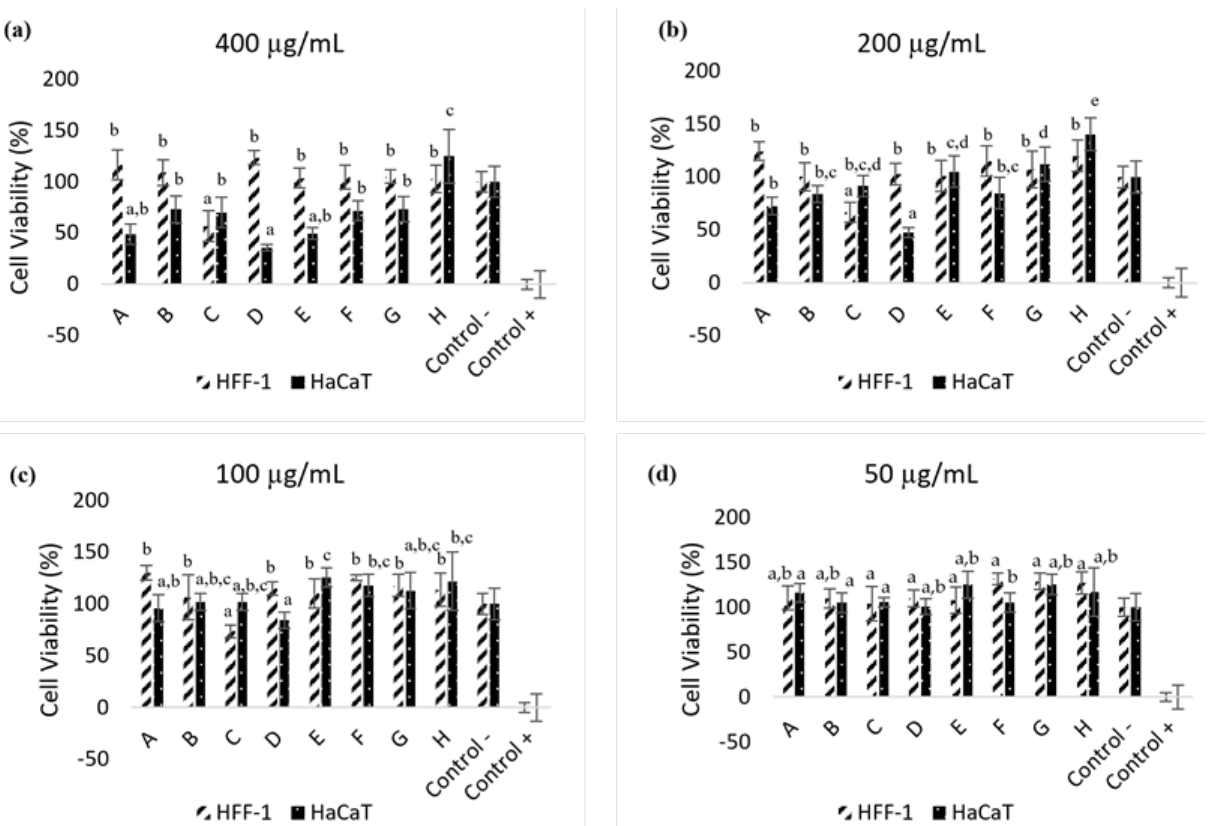
Figure 2. Cell viability effects of hydroethanolic extracts from winemaking residues on HFF-1 and HaCAt cells at different concentrations: ( a ) 400 µ g/mL; ( b ) 200 µ g/mL; ( c ) 100 µ g/mL; and ( d ) 50 µ g/mL. Values are expressed as means ± SD. In each extract, different letters mean significant differences between the concentrations ( p < 0.05). A — Red Wine Lees (Solid Phase); B — Red Grape Pomace; C — White Wine Lees; D — Diatomaceous Earth; E — Red Wine Lees (Liquid Phase); F — Seeds; G — Skins; H — Stems.